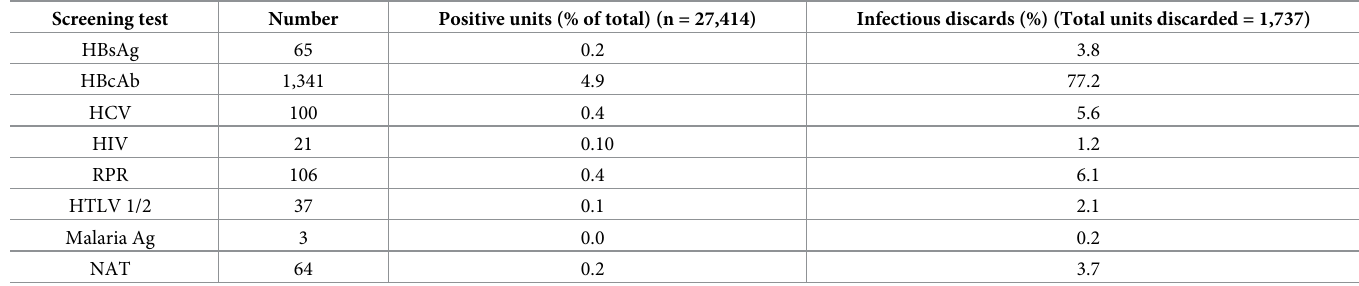
Table 2. Infectious screening markers for donors. Screening test